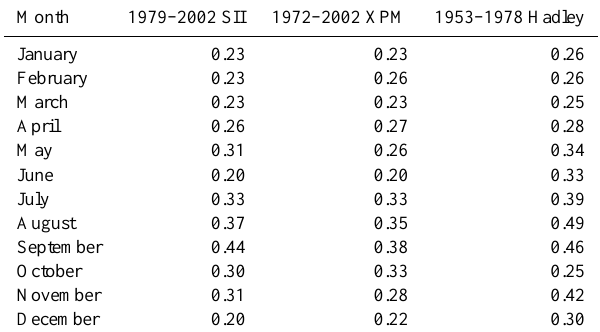
Table 1. Monthly standard deviation of detrended time series for SII, XPM, and Hadley extents for their respect periods of record. For SII, only the 1979–2002 period is used to avoid the acceleration in the downward trends in the last decade; the 2002 end matches the end of the XPM period as